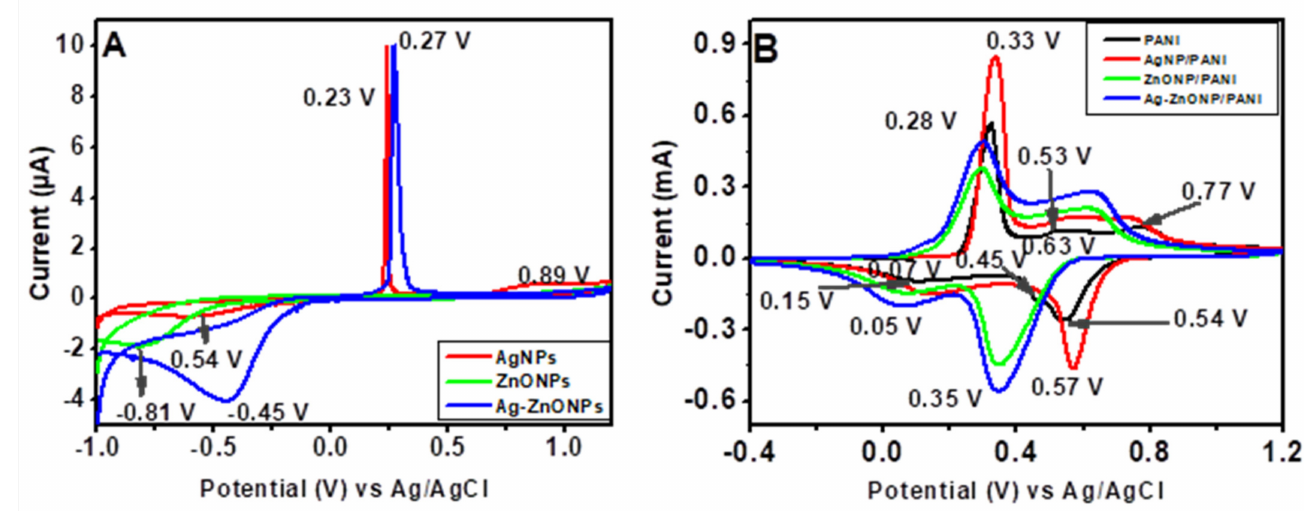
Figure 8. ( A ) CVs of AgNP–GCE, ZnONP–GCE and Ag–ZnONP–GCE at a scan rate of 10 mV/s in 1 M HCl. ( B ) CVs of PANI|GCE, AgNP–PANI–GCE, ZnONP–PANI–GCE, and Ag–ZnONP–PANI–GCE at a scan rate of 10 mV/s in 1 M